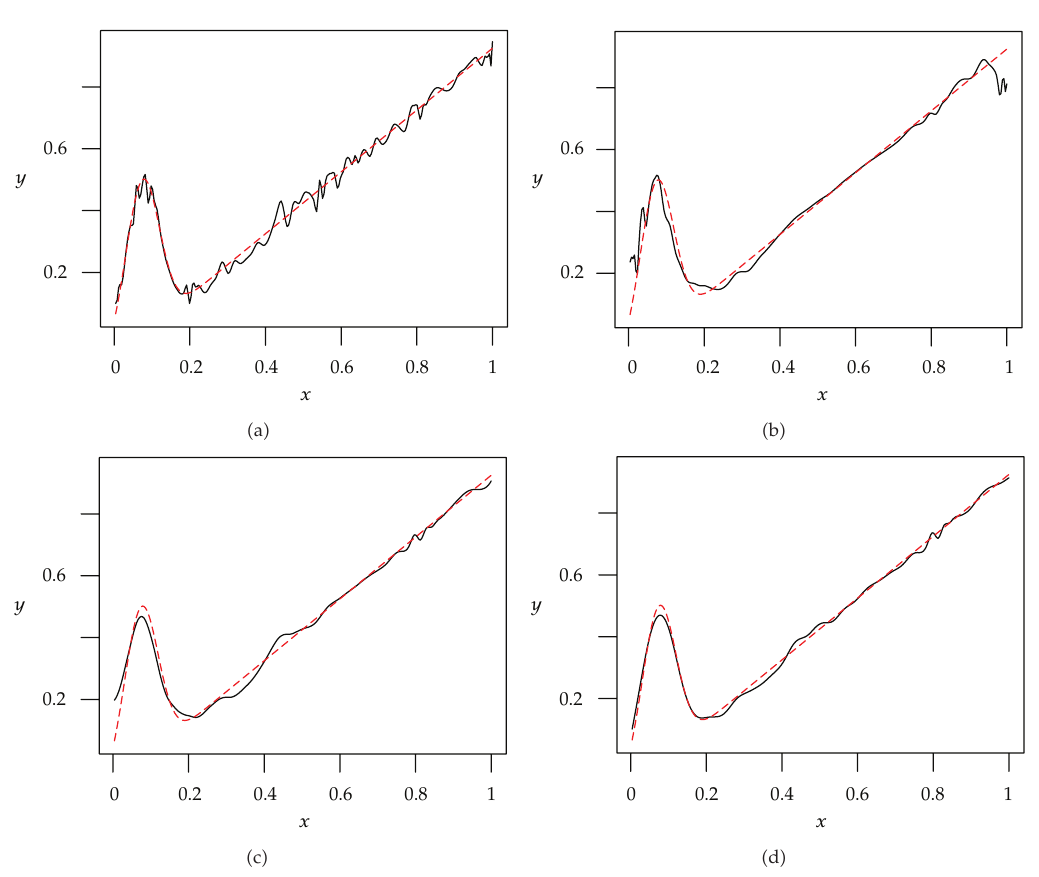
Figure 1: Curve estimation of data with correlated noise: (cid:5) a (cid:6) fitted by level-dependent thresholding, (cid:5) b (cid:6) fitted by the method of Kovac and Silverman (cid:7) 5 (cid:8) , (cid:5) c (cid:6) fitted by the first proposed method, and (cid:5) d (cid:6) fitted by the second proposed method. The black line is the fitted curve, while the red is the true